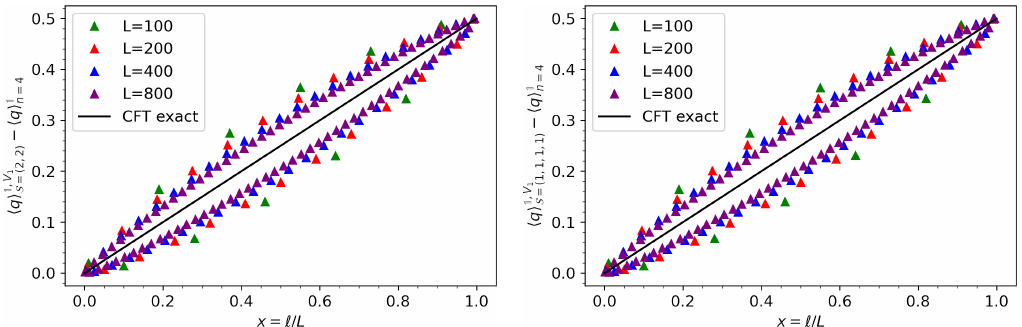
for the partitions S = (2 , 2) and S = (1 , 1 , 1 , 1) Figure 3 . Excess of average charge h q i 1 ,V 1 − h q i 1 S 4 (left/right panel respectively) as a function of x = ‘/L . The CFT predictions are tested against numerical data for the XX chain for different system sizes ( L = 100 , 200 , 400 , 800 ). The order of insertion of the operator is different in the two cases, indeed V is present in the first and second 1 replica for S = (2 , 2) while for S = (1 , 1 , 1 , 1) it is inserted in the second and fourth replica; nevertheless, the analytical prediction is the same which is a special feature of the vertex